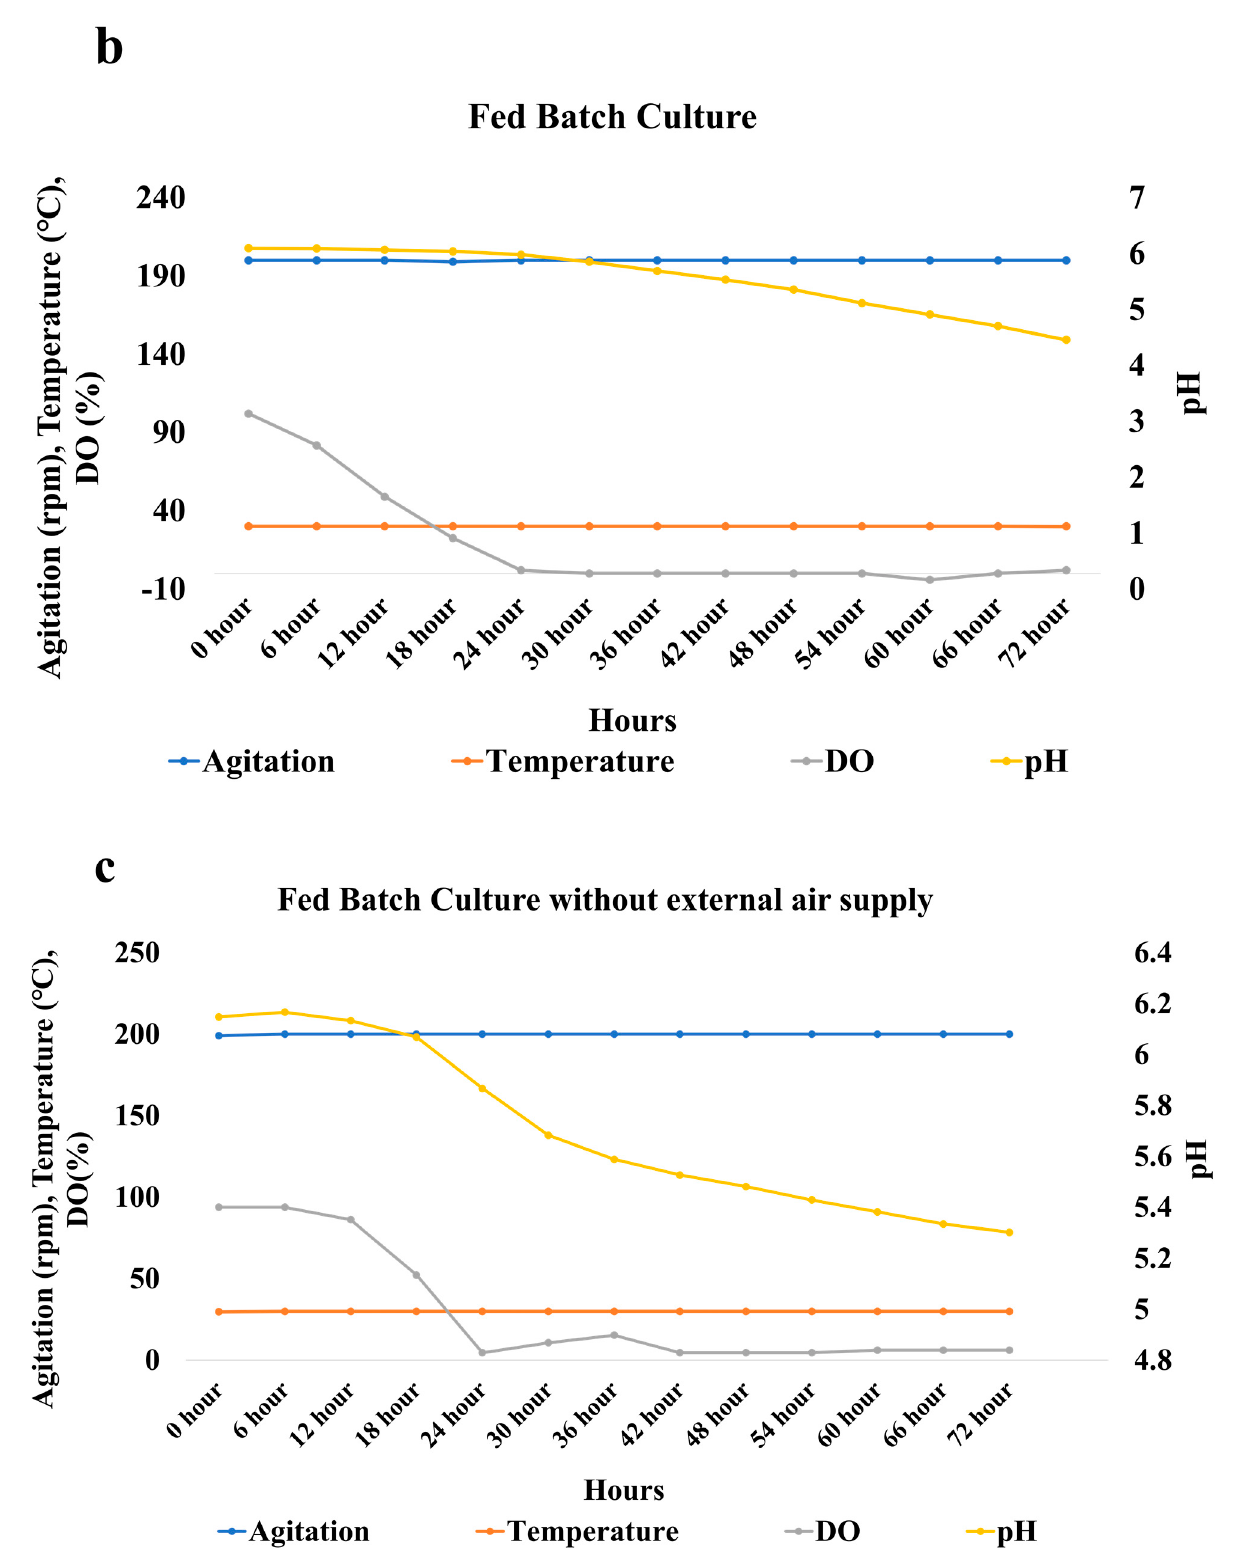
Figure 9. Graph representing changes in Dissolved Oxygen and pH with time in ( a ) Batch Culture, ( b ) Fed-Batch Culture, and ( c ) Fed-Batch Culture without an external air supply.